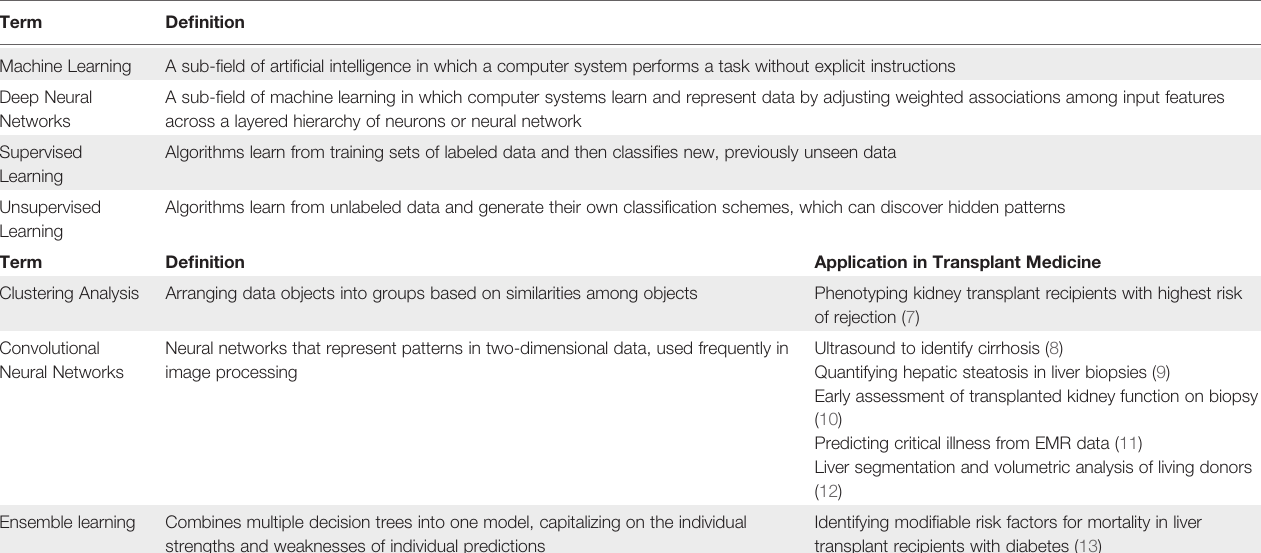
Table 1 . Major applications of machine learning in solid organ transplantation are illustrated in Figure 1 .